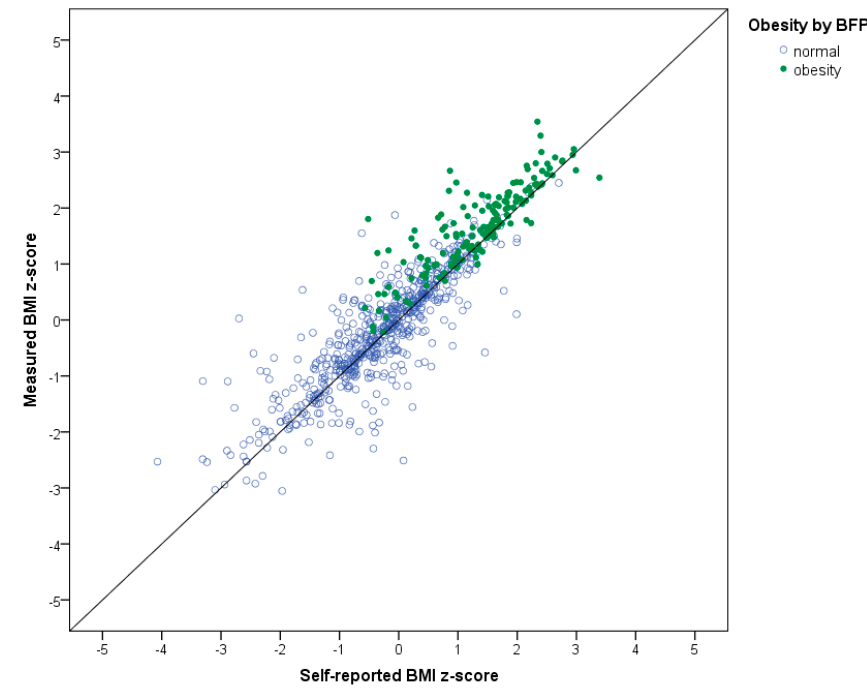
Figure 1. z-Scores of measured and self-reported BMI classified with overweight / obesity based on body fat percentage.